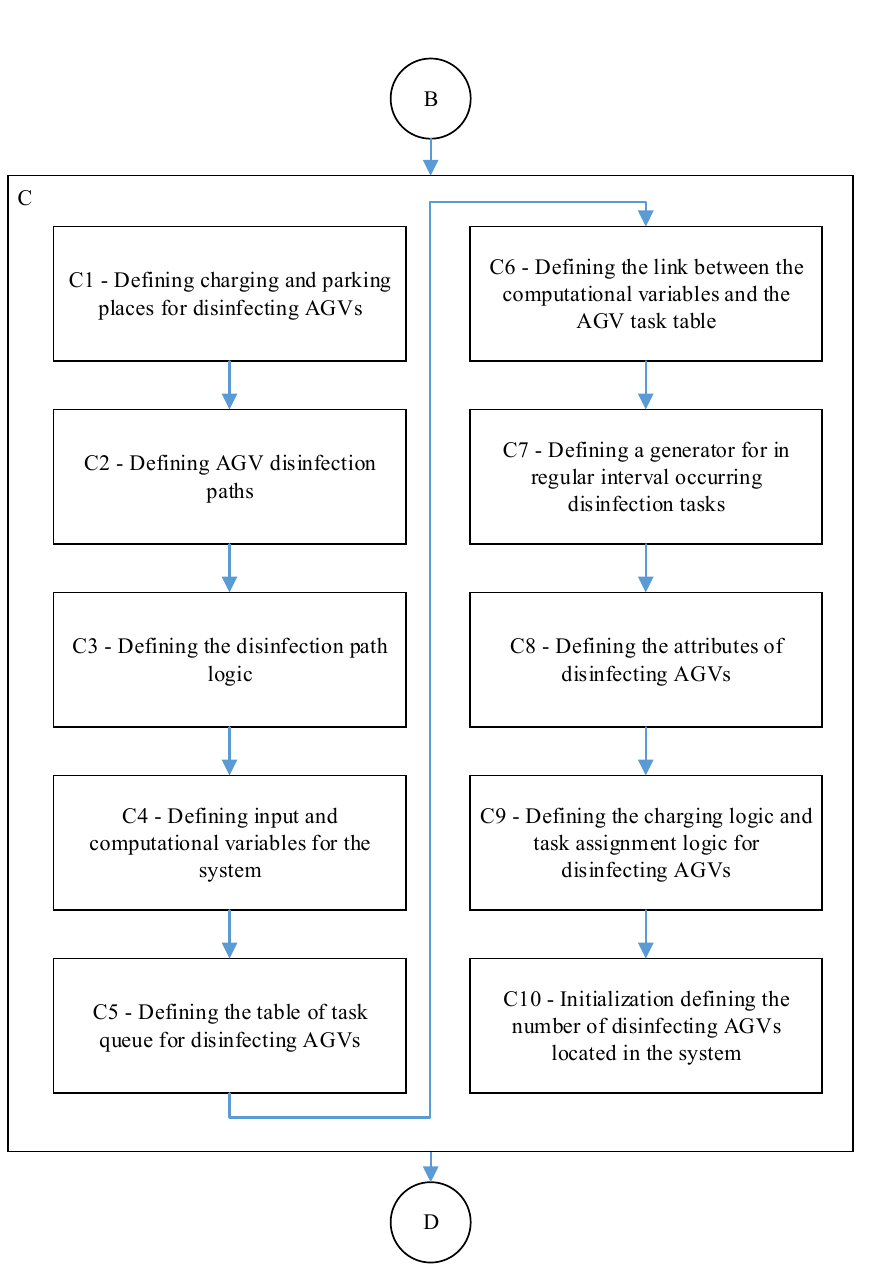
Figure 4. Block C phase of the creation of the simulation model for the disinfection AGV. Input Data for